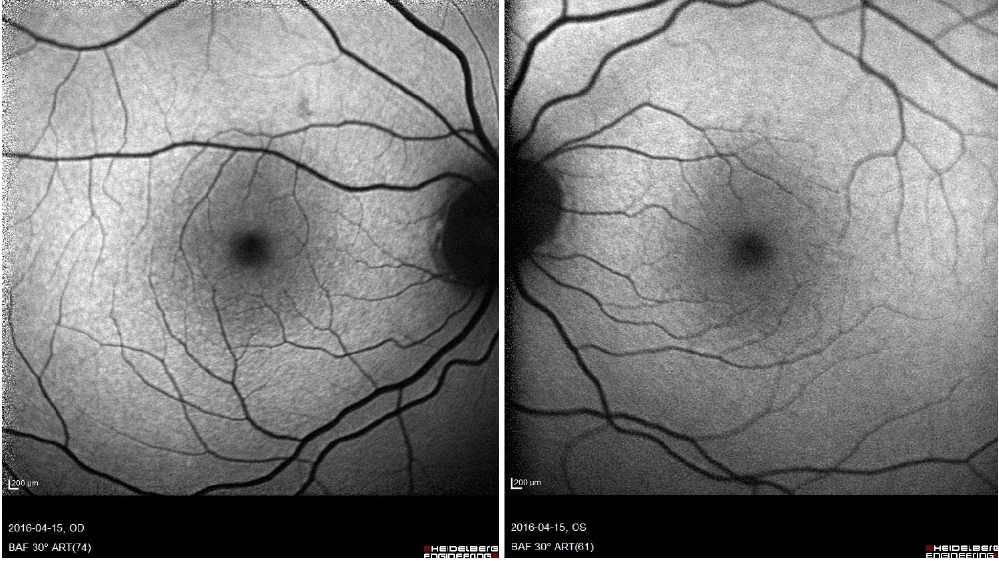
Figure 3: Short-wavelength fundus autofluorescence (SW-FAF) images of both eyes: no changes